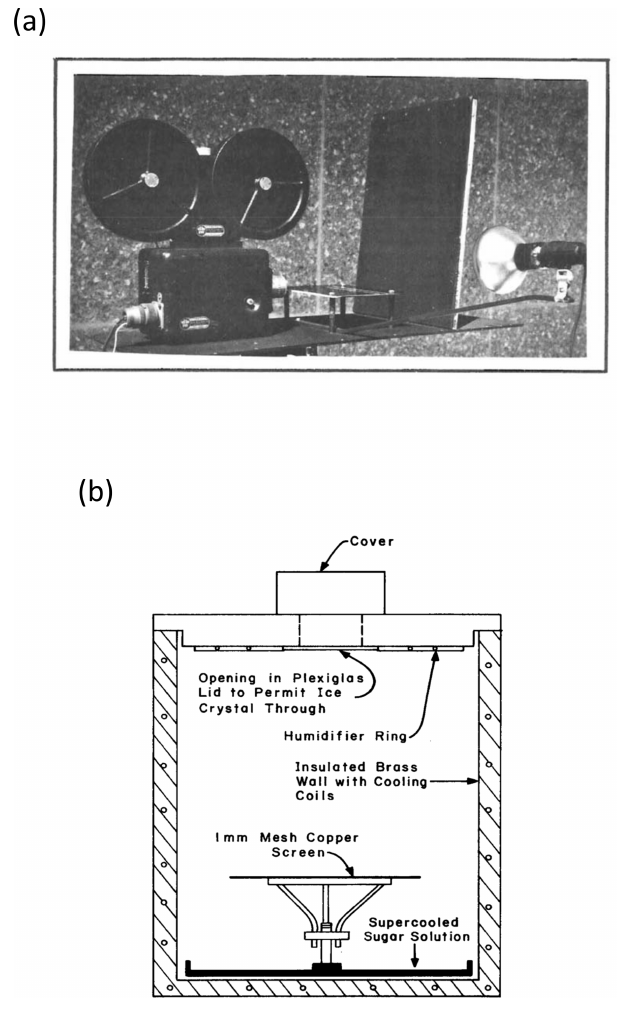
Figure 1. The portable instruments used to determine the number of fragments from natural falling ice particles. They were placed out- doors on the ground with natural ice falling into them. Field obser- vations in the winter of 1973–1974 were made, with the simplified setup in (a) , with a l6mm movie camera, a black Plexiglas plate and an optically black background. This instrument had been previously verified as realistic by the use of the portable chamber in (b) , with ice particles falling through the hole in the top and into the chamber and breaking on impact with the copper screen. Where, in (a) , frag- ments were counted only by inspection of the video footage, they were counted in (a) by eye after falling through the mesh into the supercooled solution. Source: Vardiman (1978). © American Mete- orological Society. Used with permission.